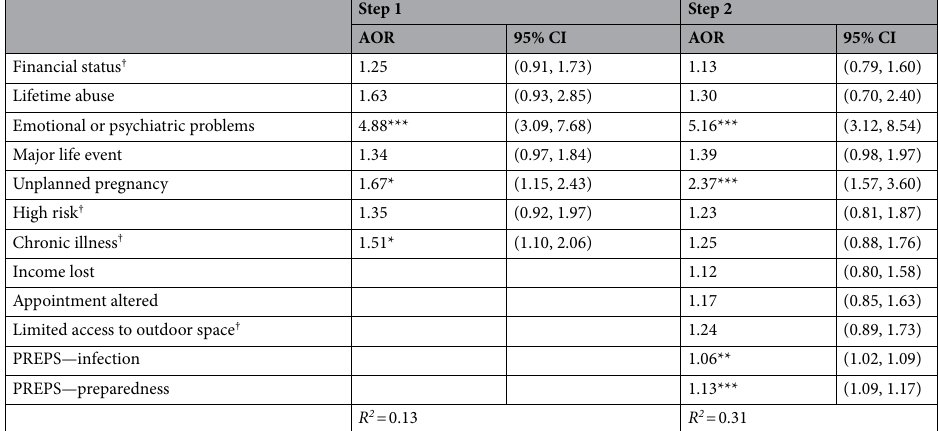
Table 4. Binary hierarchical logistic regression predicting moderate or severe anxiety symptoms ( N = 1050). AOR adjusted odds ratio, CI confidence interval. * p < 0.05, ** p < 0.01, *** p < 0.001. † Women who reported below average or average financial status were grouped together; Women who reported sometimes or rarely having access to outdoor space were grouped together; Women who reported having a chronic illness and those who were unsure were grouped together; Women who reported being high risk and those who were unsure were grouped